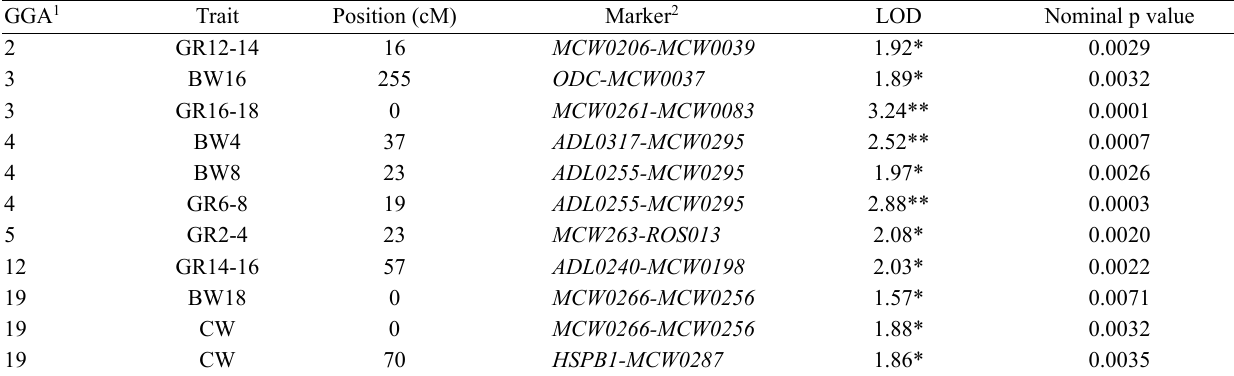
Table 2. Summary of QTL results for growth-related traits in Korean native chicken GGA 1